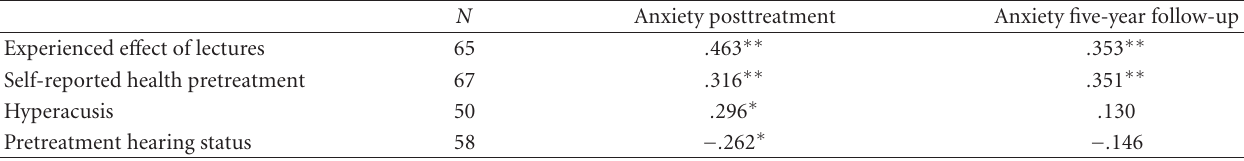
Table 3: Results from bivariate correlation analyses over factors associated with the degree of tinnitus-related anxiety. N Anxiety